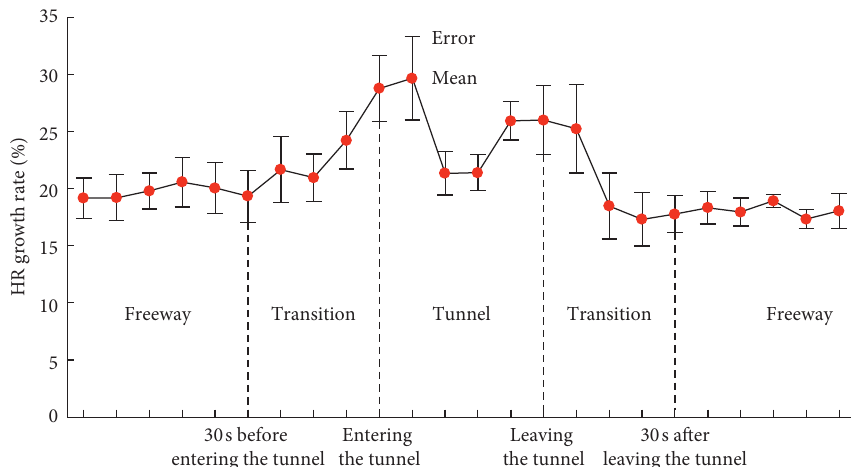
Figure 4: Changes of HR growth rate during driving through a